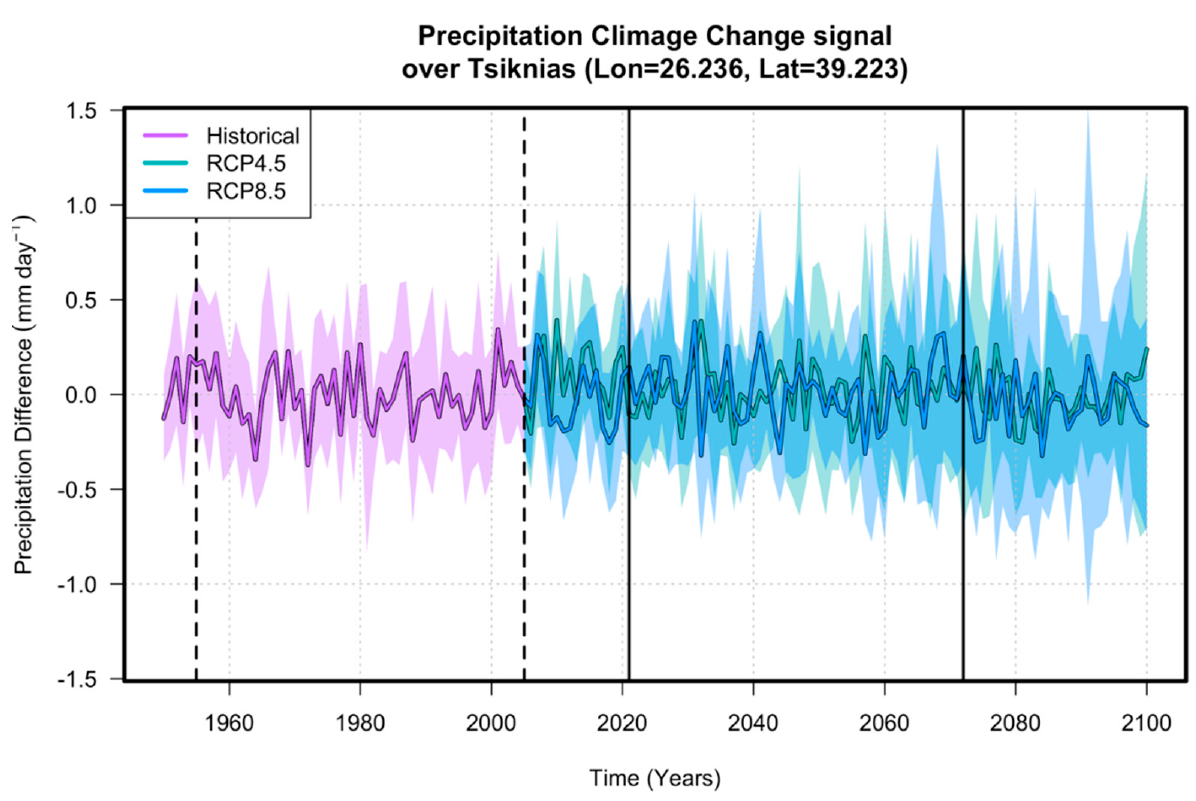
Figure 8. Multi-model simulated time series at Tsiknias (Lesvos) from 1950 to 2100 indicating the changes in annual precipitation relative to the period 1961–1990 for the historical, RCP 4.5, and RCP 8.5 experiments. Lines and shades represent the ensemble mean and standard deviation of all the available CORDEX models, respectively. Vertical dashed and continuous lines delimit the periods 1955–2005 and 2021–2071, respectively.